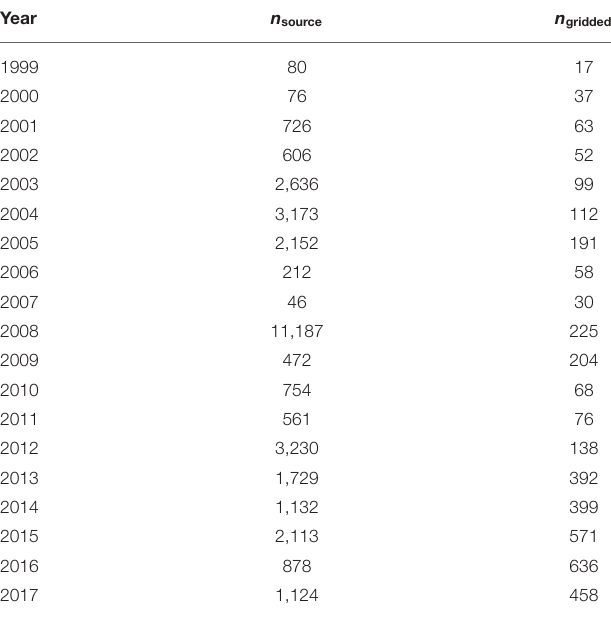
TABLE 1 | Distribution of coral cover data points by year in source and final gridded data